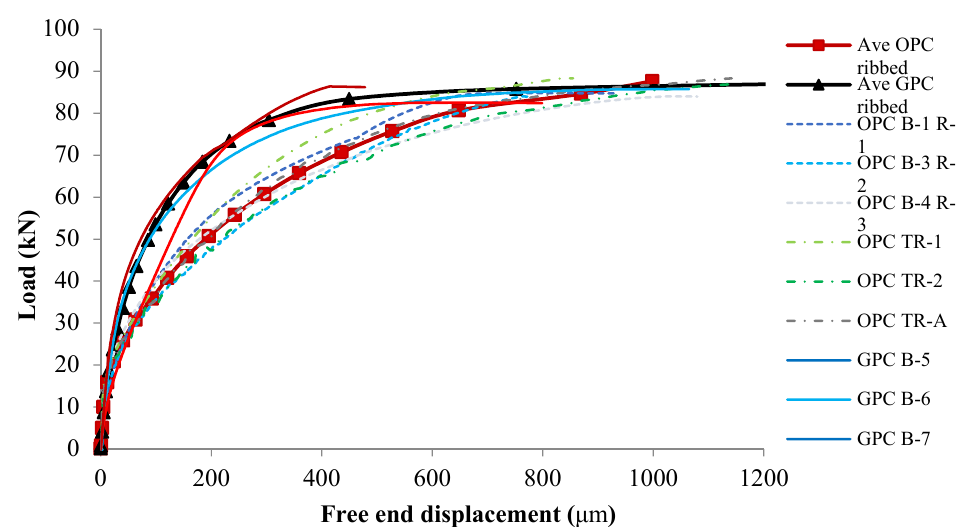
Figure 16. Load–slip graphs of ribbed bar reinforced OPC and GPC.